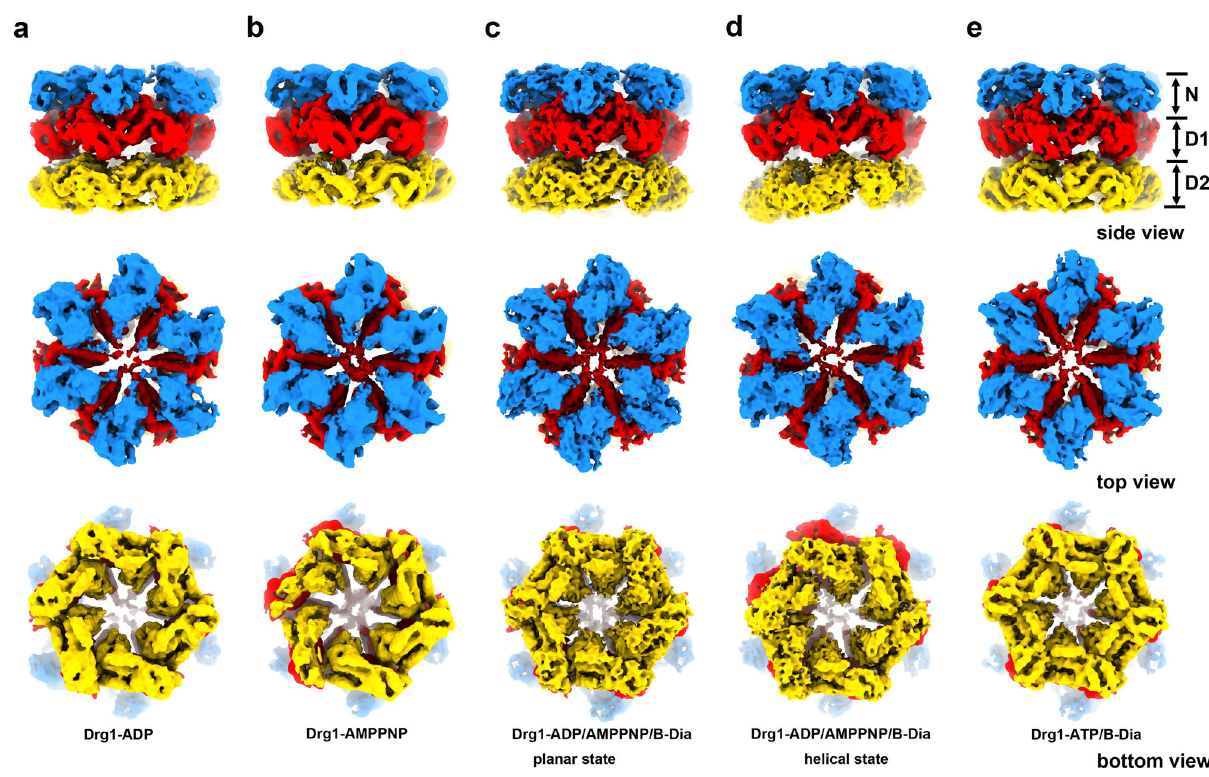
Fig. 1 | Representative cryo-EM structures of wild type Drg1 hexamers in dif- ferent nucleotide and benzo-diazaborine binding states. a – e Representative cryo-EMmaps of Drg1 hexamers treated with ADP ( a ),AMPPNP( b ), ADP/AMPPNP/